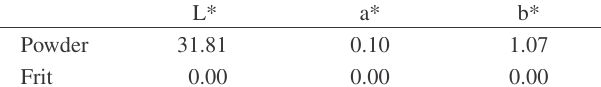
Table 2. Colorimetric coordinates of powder calcined at 900 °C for 8 hours.